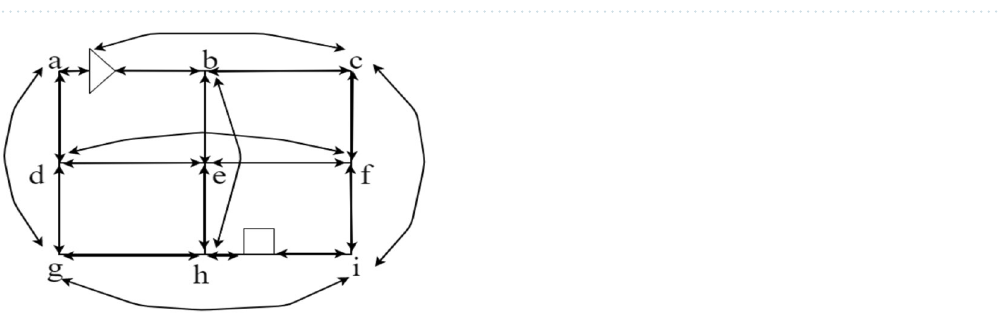
Figure 11. Four-way shuttle access path weighting diagram (the triangle in the diagram represents the four-way shuttle location, the square represents the access cargo position).